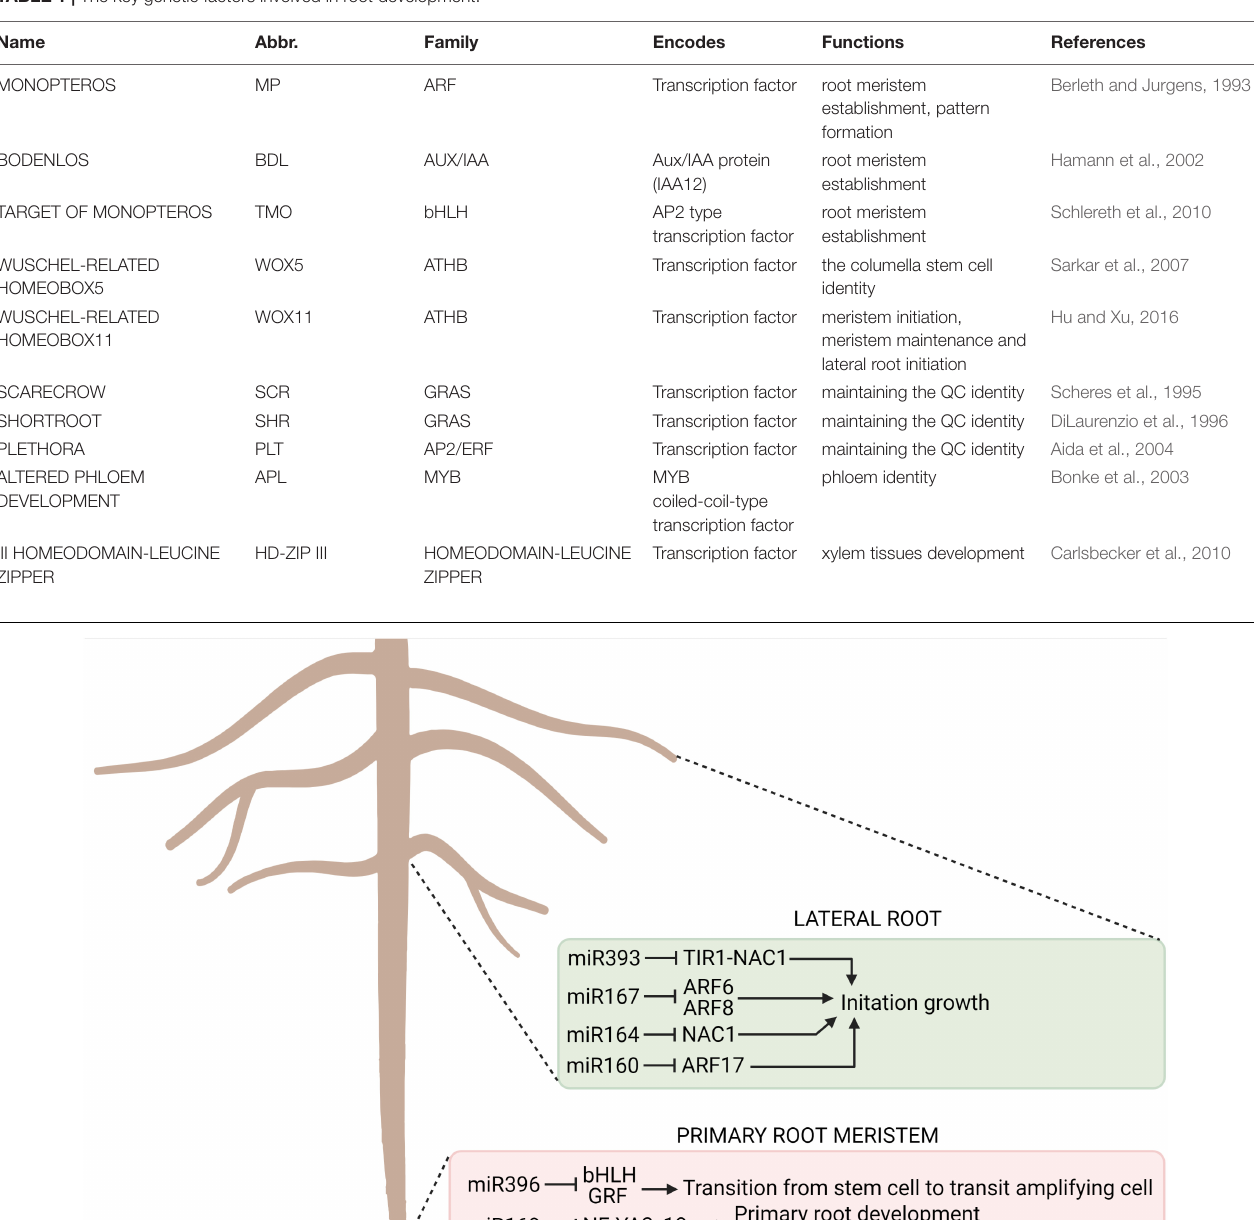
TABLE 1 | The key genetic factors involved in root development.